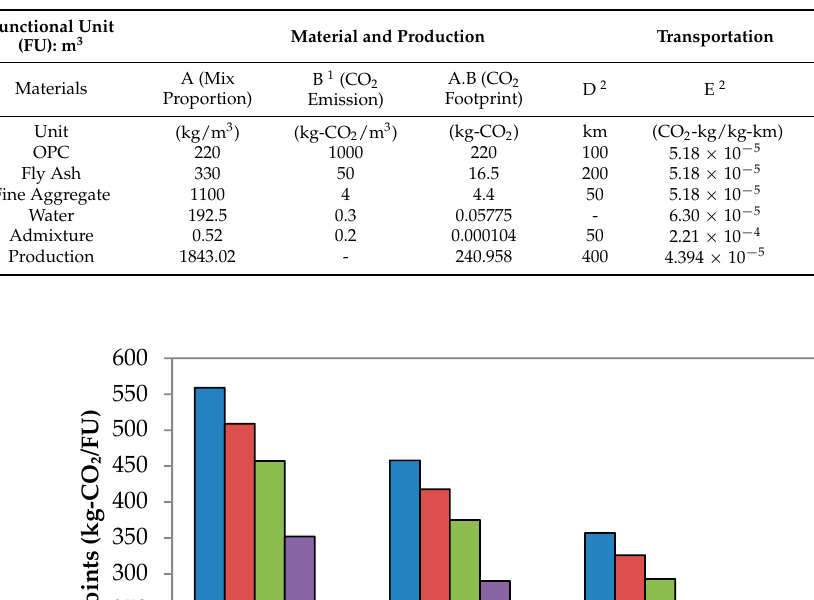
Table 11. Eco-points’ assessment for OPC + 60% fly ash compacting mortar.